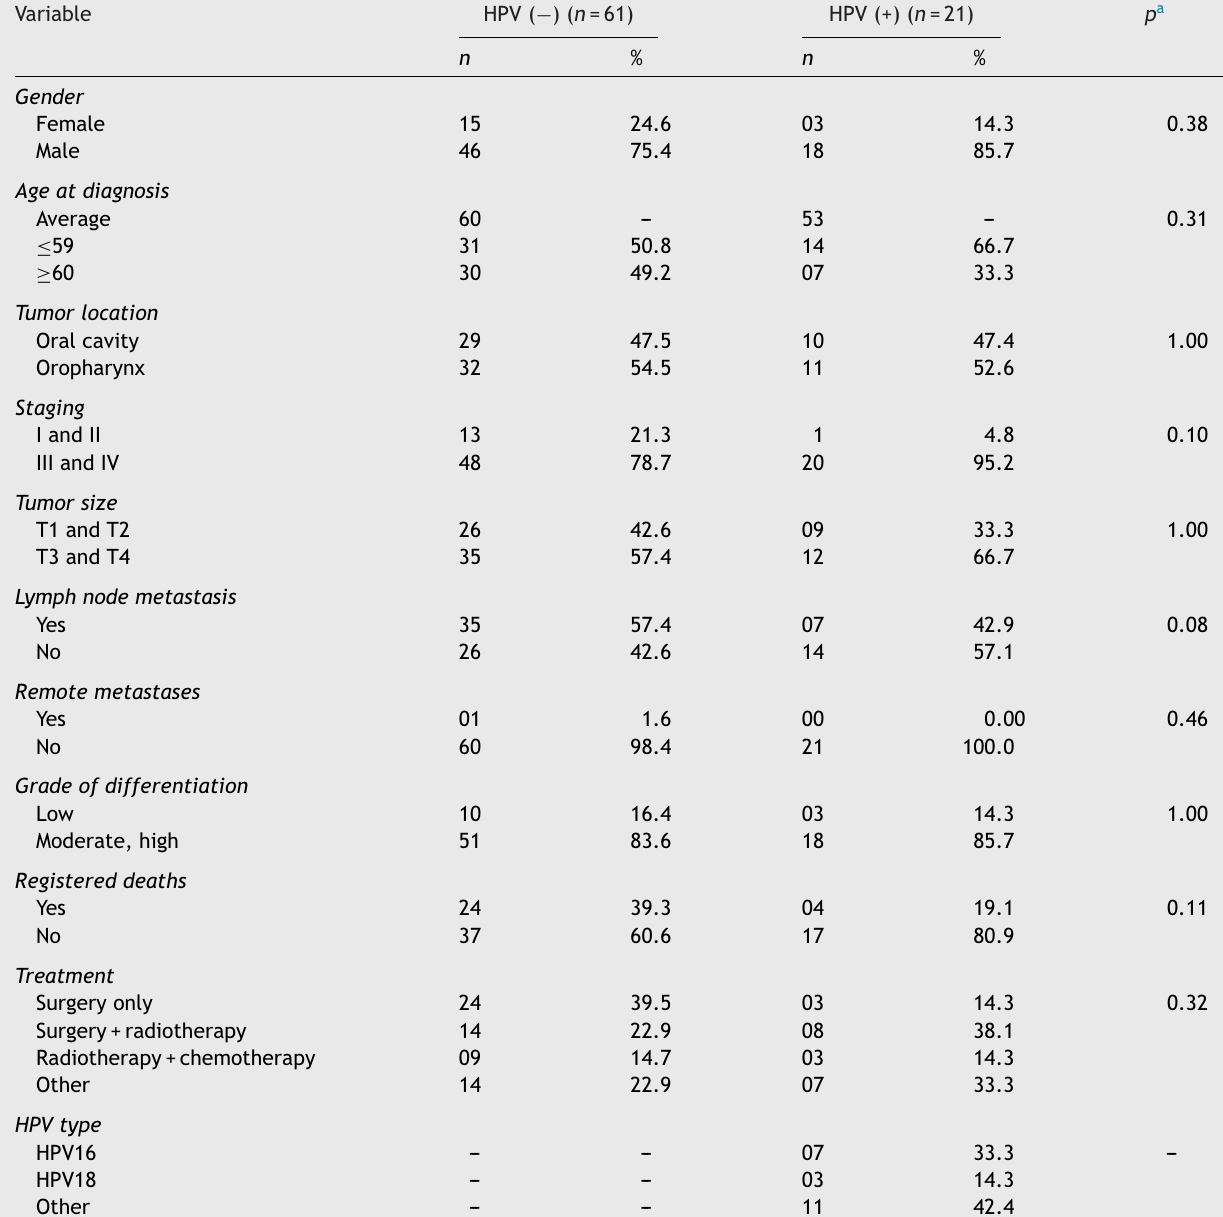
Table 2 Analysis of the clinical and histological characteristics of the patients with HPV-positive and HPV-negative oral cavity and oropharynx